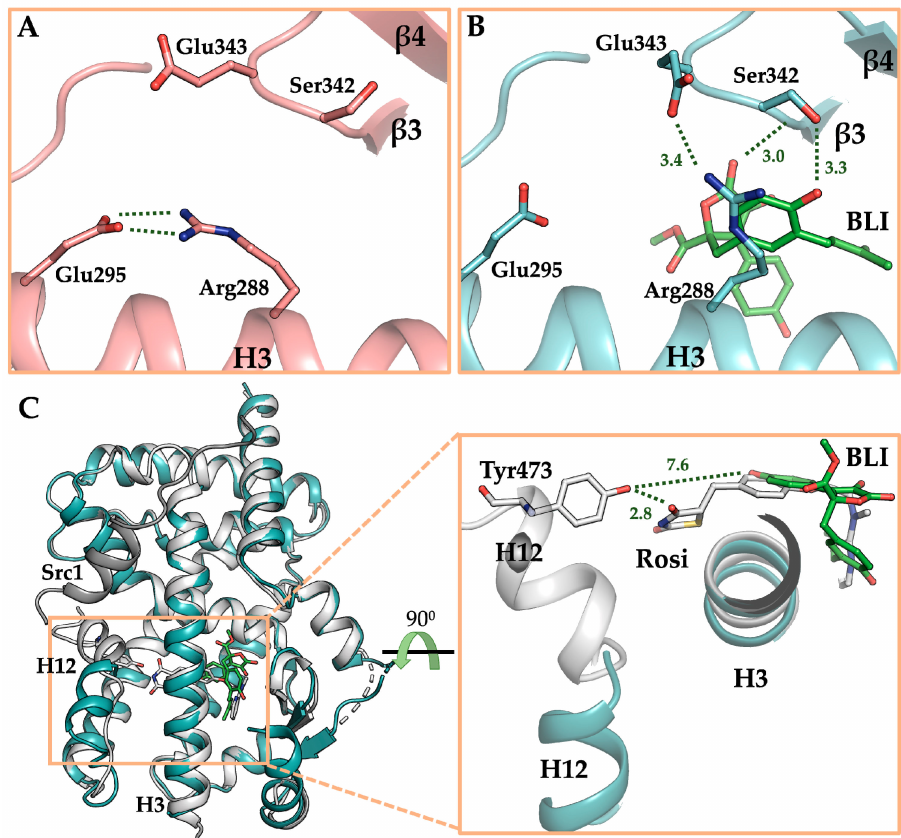
Figure 5. Binding mode of butyrolactone I to PPAR γ LBD. ( A ) Ligand binding pocket (LBP) of ligand-free PPAR γ LBD. ( B ) LBP of butyrolactone I-bound PPAR γ LBD. The structures of ligand-free PPAR γ LBD and butyrolactone I-bound PPAR γ LBD are displayed as cartoon representations in salmon and cyan, respectively. Butyrolactone I shown as green-colored stick model occupied LBP. Residues inducing conformational changes upon binding of butyrolactone I to PPAR γ LBD (Arg288, Ser342, and Glu343) are shown as stick models and hydrogen bonding networks are depicted by green-dashed lines. ( C ) Comparison of the structures of rosiglitazone (Rosi)-bound PPAR γ LBD and butyrolactone I-bound PPAR γ LBD. The structures of rosiglitazone-bound and butyrolactone I-bound PPAR γ LBD are superposed and shown as cartoon representations in white and cyan, respectively. The structure of rosiglitazone-bound PPAR γ LBD is shown in its active conformation in the presence of co-activator Src1 colored in dark grey. In the close-up view of PPAR γ LBP, rosiglitazone and butyrolactone I are displayed as stick models in white and green, respectively. Tyr473 on H12 is displayed as a stick model and distances between Tyr473 and rosiglitazone or butyrolactone I are depicted by dashed